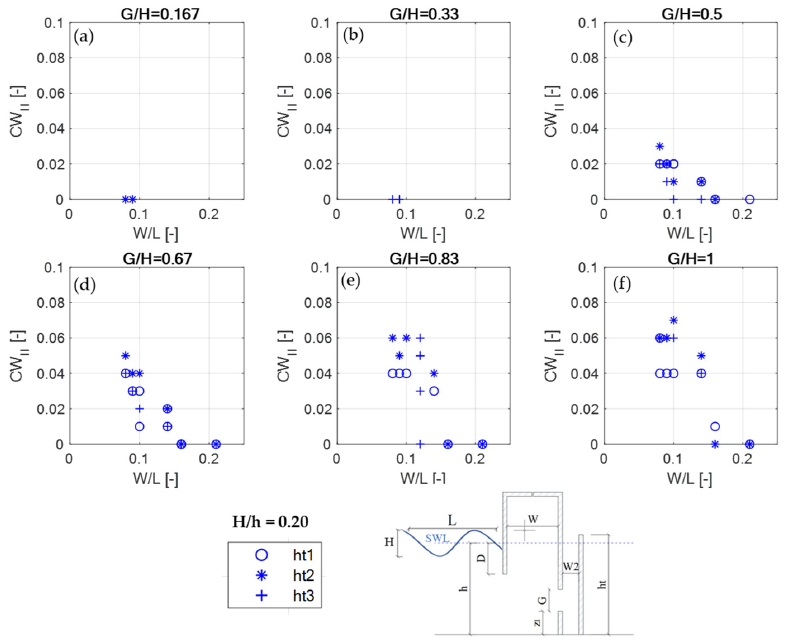
Figure A1. Capture width of the overtopping-based component of the device, CW II , as a function of the width of the OWC chamber, W / L , for different sizes of the aperture in the back wall relative to the incident wave height G / H = 0.125 ( a ), 0.25 ( b ), 0.375 ( c ), 0.5 ( d ), 0.625 ( e ), 0.75 ( f ). Results obtained with the wave height H / h = 0.20.